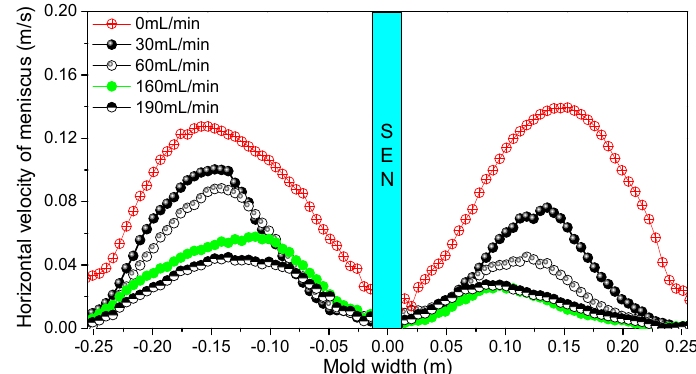
Figure 19. Effect of gas flow rate on the surface horizontal velocity.